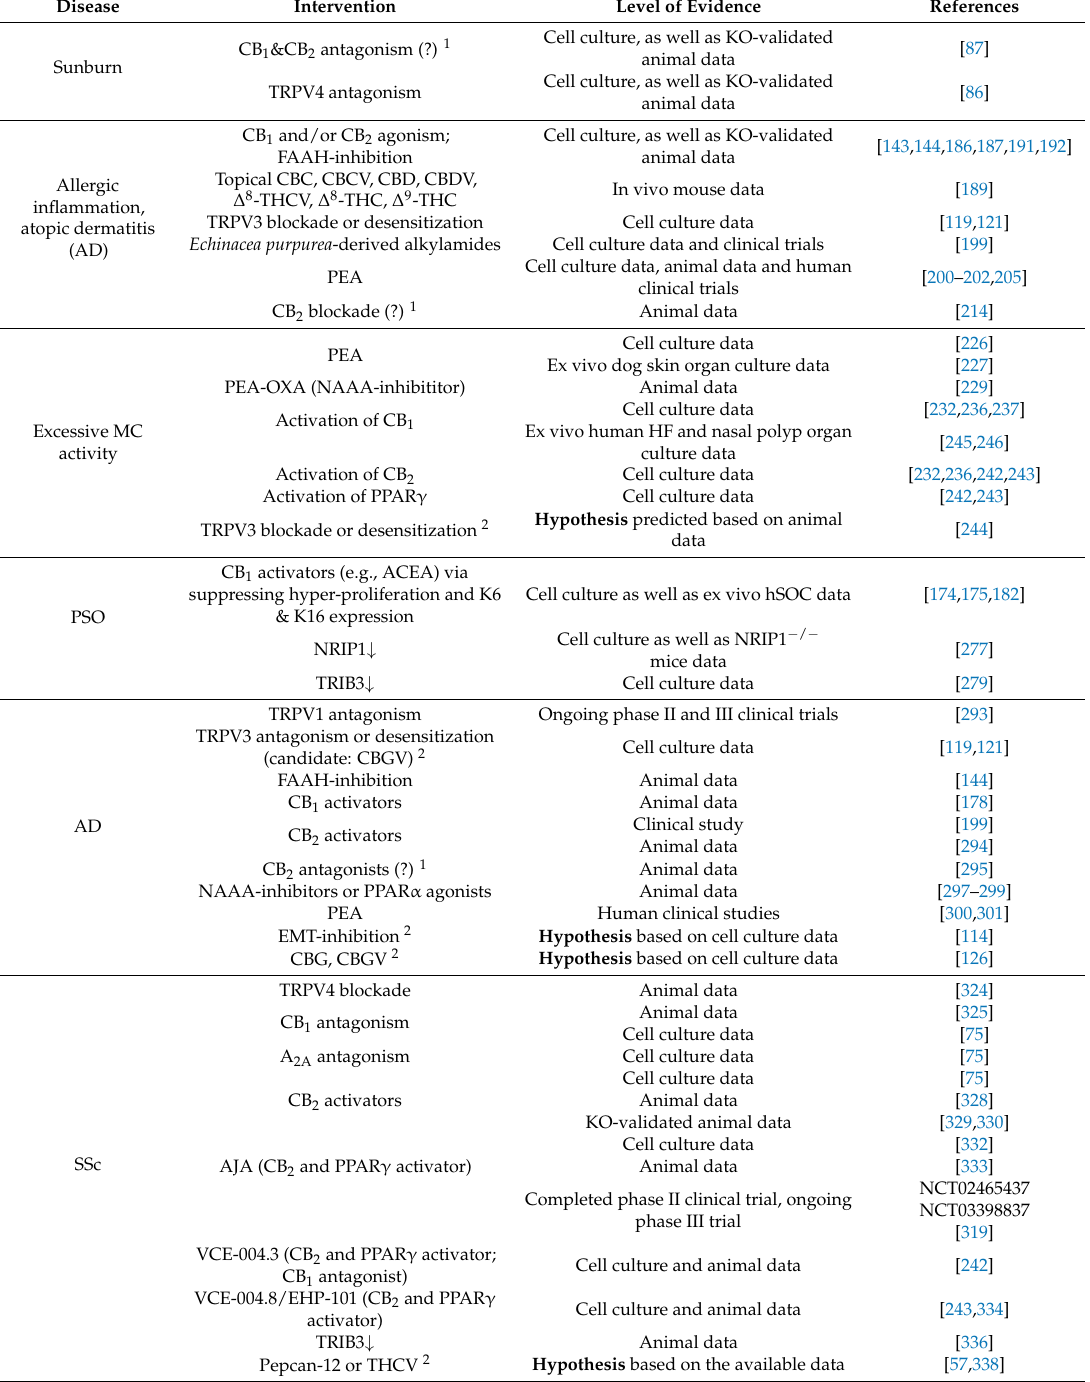
Hypothesis based on the available